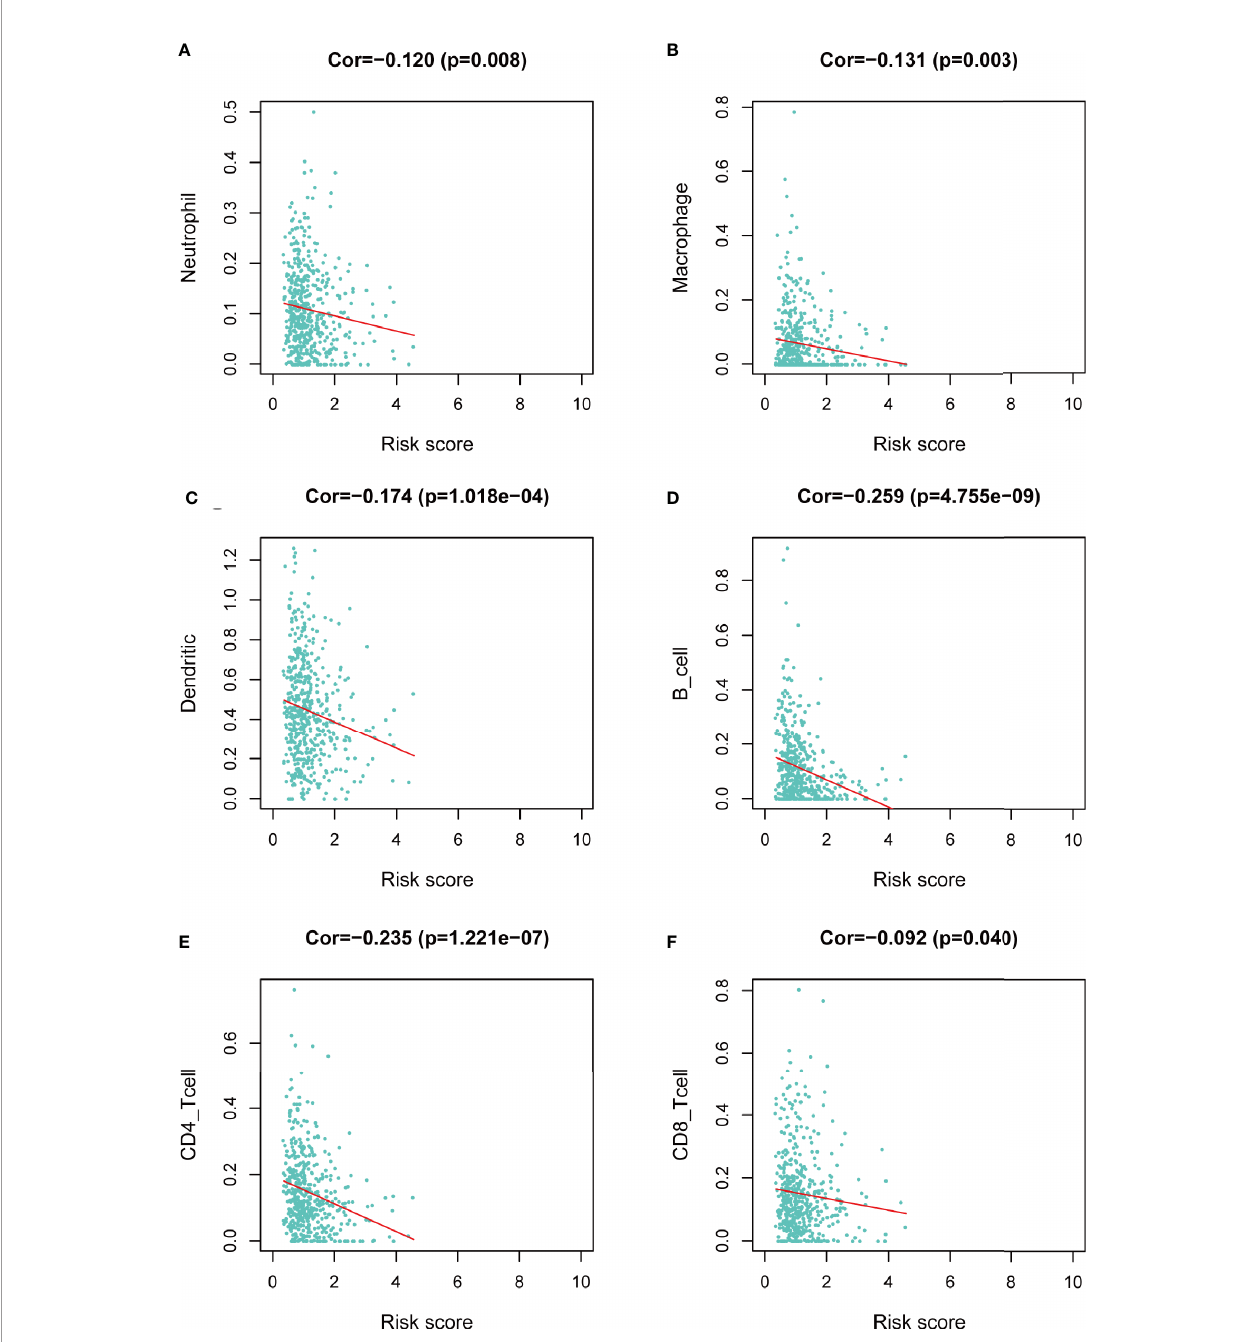
FIGURE 7 | Correlation between risk score and in fi ltrating immune cells in the LUAD tumor microenvironment. (A) Neutrophil. (B) Macrophage. (C) Dendritic cell. (D) B lymphocyte. (E) CD4 + T lymphocyte. (F) CD8 + T